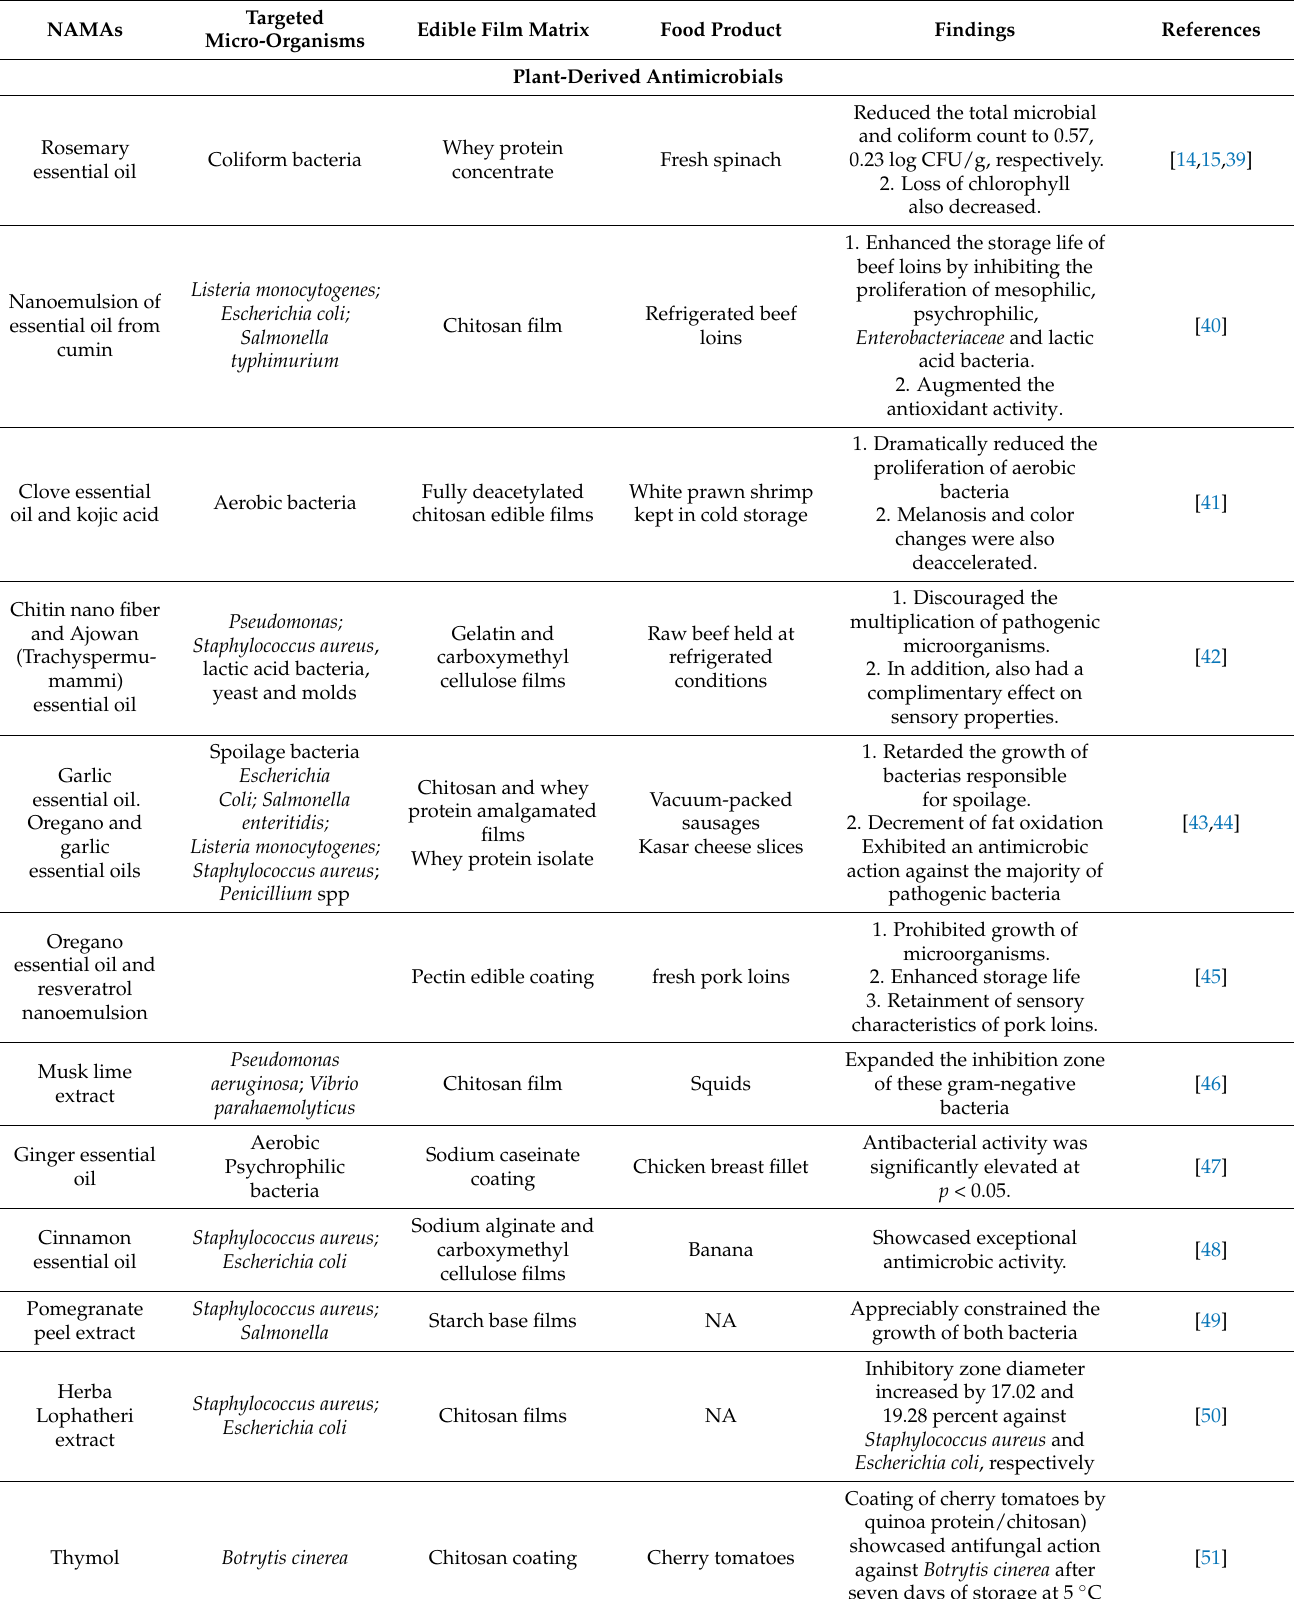
Table 1. Overview of NAMAs derived from various sources in edible packaging and their effects.